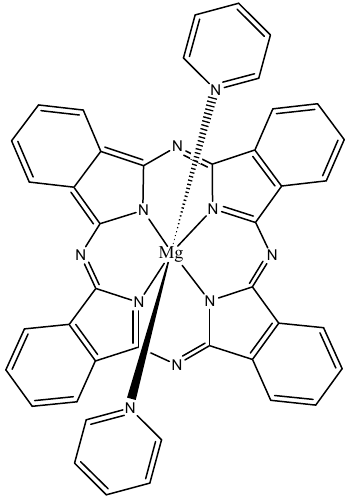
Figure 19. A Mg tetrabenzoporphyrin having high 1 O 2 quantum efficiency.